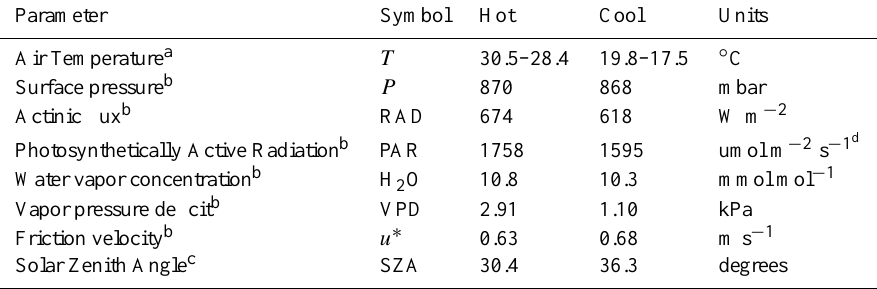
Table 2. Meteorological observations. Parameter Symbol Hot Cool Units Air Temperature